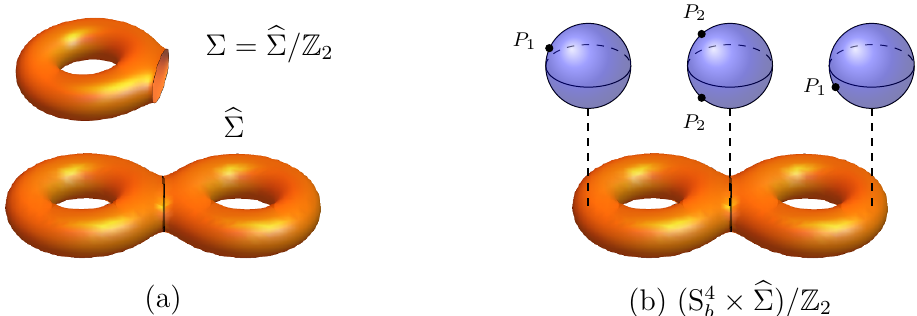
Figure 1 . (a) An involution turns a Riemann surface without boundaries b (cid:6) into one with bound- aries (cid:6). (b) The lift of this construction to a 6d orbifold. We indicate how it acts on the ellipsoid S 4 The singular locus is S 3 (cid:2) S 1 , where the (cid:12)rst factor corresponds to the equator of the middle ellipsoid b and the second factor to the boundary of the Riemann